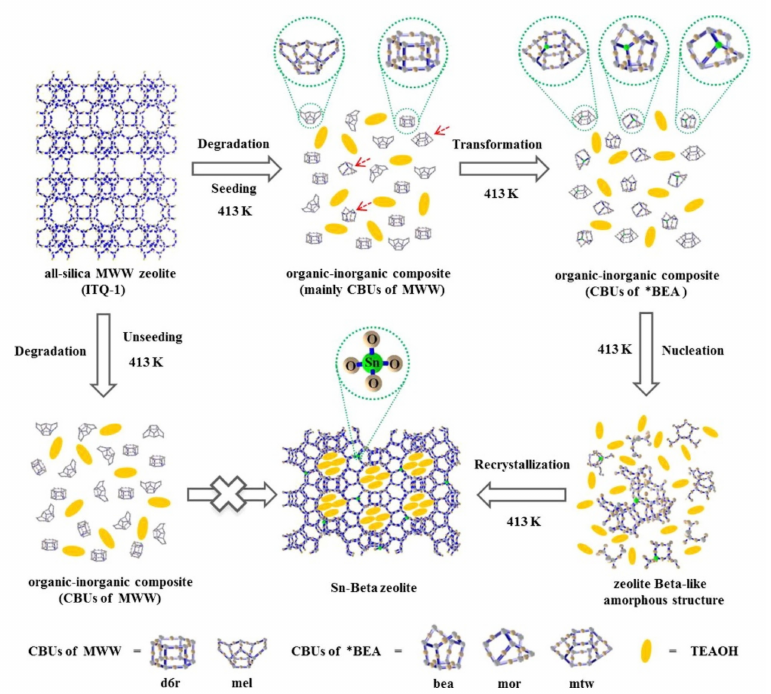
Figure 3. Schematic representation of the proposed crystallization mechanism for seed-assisted trans- formation of parent MMW-type zeolite to Sn-Beta. The red arrows indicate the composite building units (CBUs) of BEA* derived from the degradation of the seeds. Reproduced with permission from [31]. Copyright 2017, Elsevier.